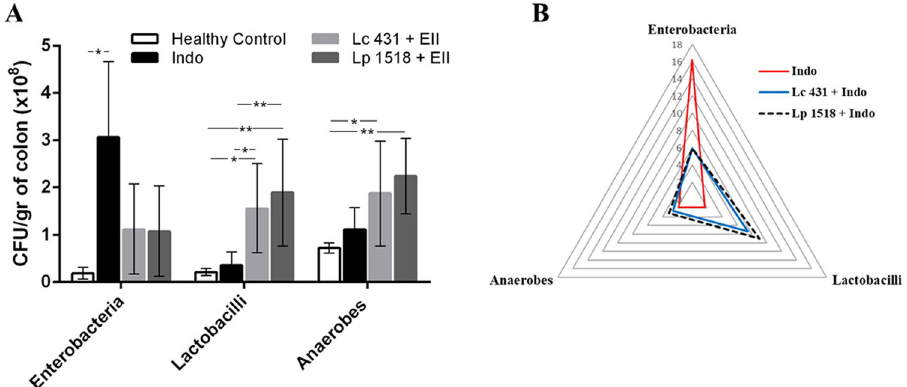
Figure 8. Microbial population in the large intestine. Balb/c mice with an indomethacin-induced intestinal inflammatory process receiving a conventional diet (Indo) or oral probiotic supplementation (Lc 431 + Indo and Lp 1518 + Indo) for 7 and 5 days, respectively. At the end of this time, samples of the large intestine were collected and total anaerobic bacteria, lactobacilli, and enterobacterial population were analyzed by plate count agar. ( A ) Results were expressed as CFU/ml per gram of large intestine (mean ± S.E.M). Three independent experiments were performed. The line at the top of the bars indicates comparison between the two groups . *p < 0.05, ** p < 0.01. ( B ) Mean scores of total bacterial population data in the experimental animals. Results are expressed as the ratio/relationship between each group and healthy